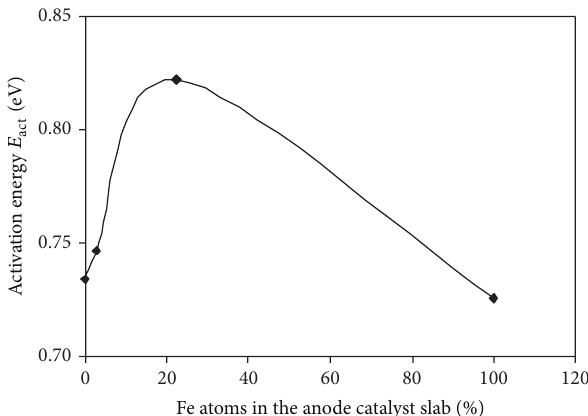
Figure 8: DFT calculated activation energy plot, 𝐸 dehydrogenation of propane; ∗ C 3 H 8 → ∗ C 3 H 7 + ∗ H ( ∗ indicating that the species is adsorbed on the surface of the catalyst) for various compositions of Ni/Fe anode catalyst slabs (0% Fe, 2.8% Fe, 22.2% Fe, and 100% Fe).